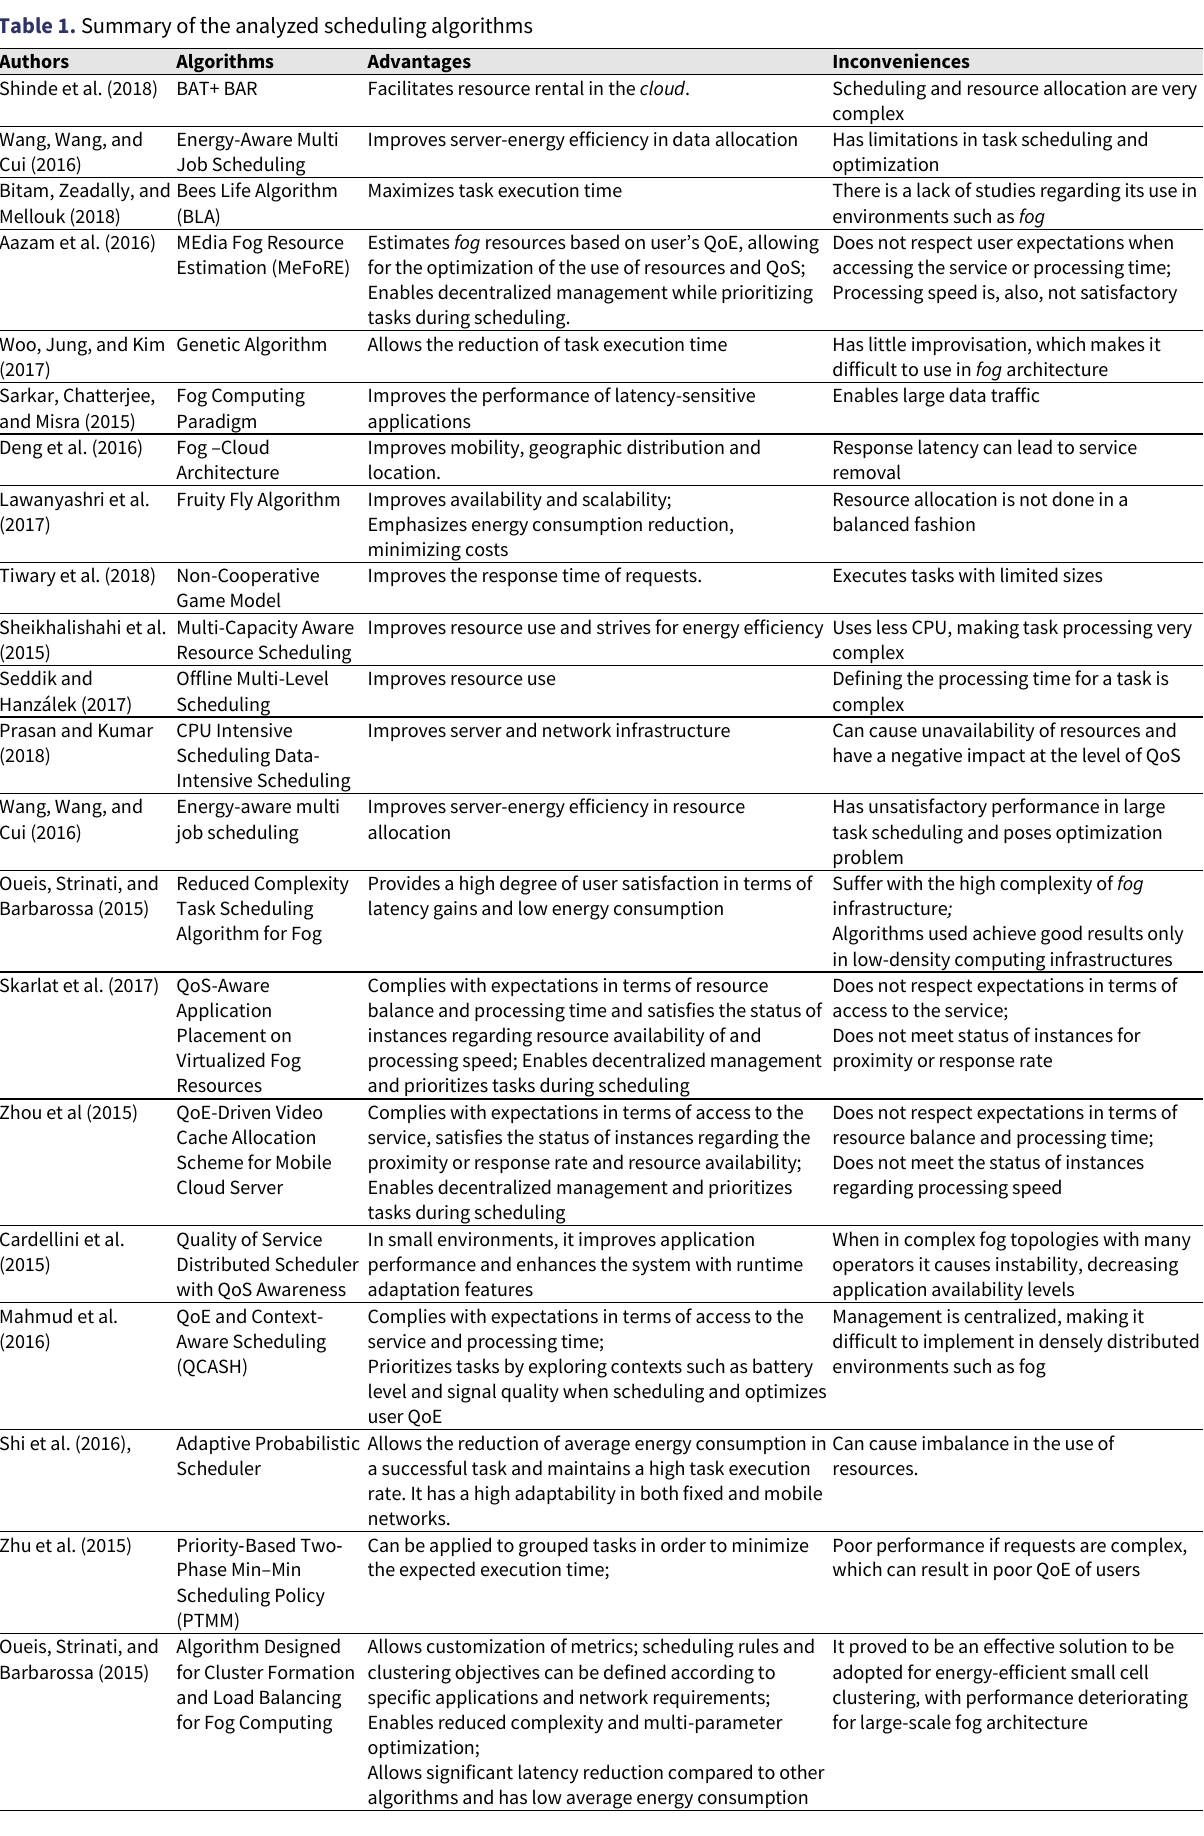
Table 1. Summary of the analyzed scheduling